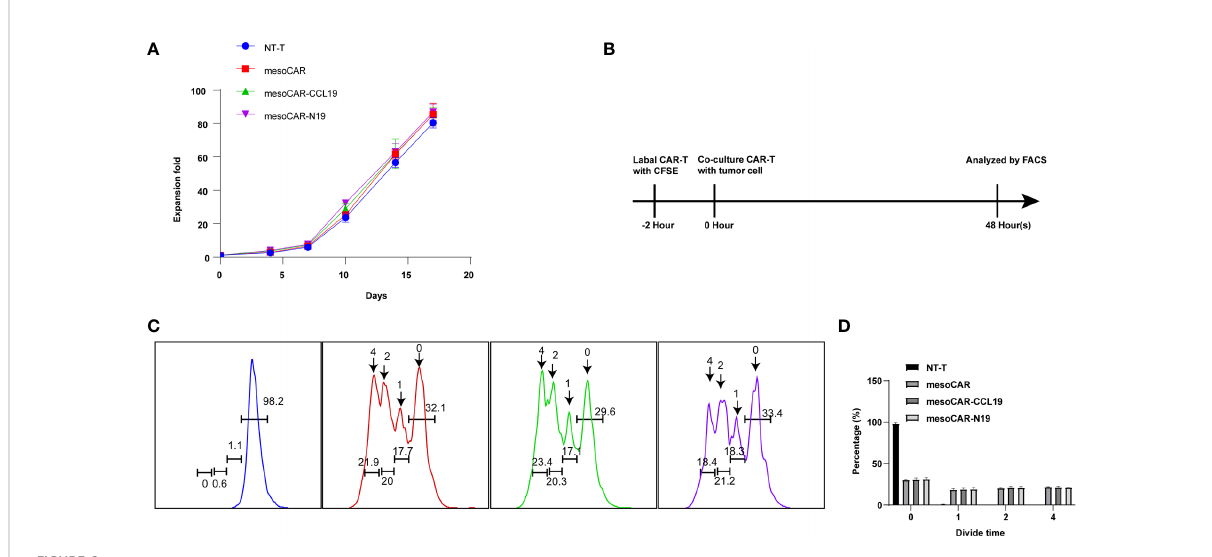
FIGURE 6 Chimeric antigen receptor T (CAR-T) cell proliferation in vitro . (A) The proliferation curve of CAR-T cells in in vitro culture by cell count; (B) Schematic diagram of the principle of carboxy fl uoresceinsuccinimidyl amino ester(CFSE) staining; (C) Flow cytometry detection of CFSE fl uorescence; (D) Cell division generation statistics summarized from CFSE staining results. n =